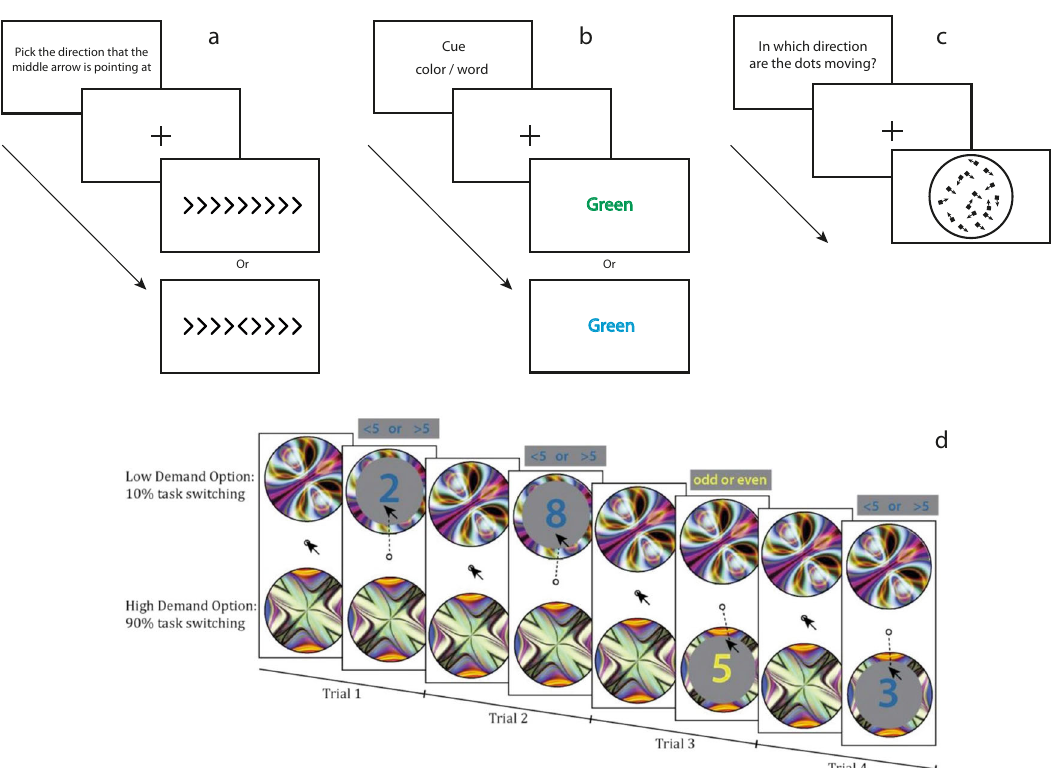
Fig. 4 Examples of tasks used to assess EF. a Flanker task: subjects indicate the direction to which the arrow in the middle points. b Stroop task: subjects are presented with the name of colour printed in a colour that either matches or mismatches the name. Subjects are asked to give the name of the written colour or the printed colour. c Motion Discrimination task: subjects have to determine in which direction the dots are going with variating levels of noise. d Example of a Demand Selection task: in both options subjects have to switch between two tasks. Task one, subjects determine whether the number shown is higher or lower than 5. Task two, subjects determine whether the number is odd or even. The two options (low and high demand) differ in their degree of task switching, meaning the effort required. Subjects are allowed to switch between the two options. Note, the type of task is solely indicated by the colour of the number and that the subjects are not explicitly told about the difference in effort between the two options (retrieved from Fig. 1c in Froböse et al. 58